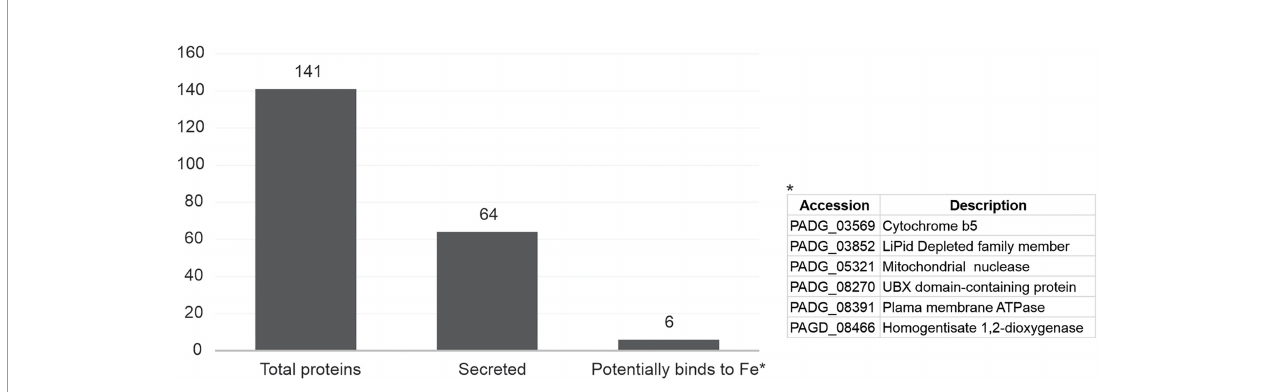
FIGURE 1 | Summary of proteomic fi ndings. P. brasiliensis yeast cells were subjected to Fe deprivation for 48 h, and fungal secreted proteins were identi fi ed by nanoUPCL-MS E . A total of 141 proteins were identi fi ed. To increase the analysis stringency, the identi fi ed proteins were submitted to analysis of secretion prediction by online tools and data available in the literature, which resulted in the number of 64 proteins. Of those 64 proteins, 6 have potential ability to bind